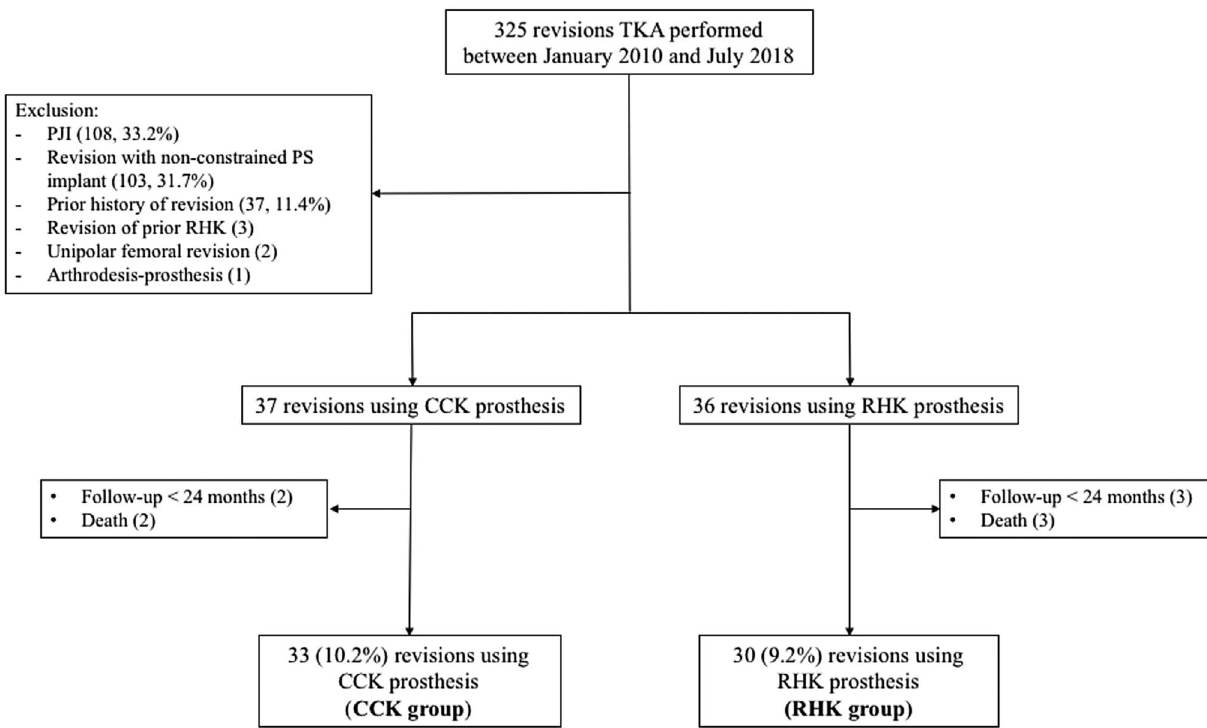
Figure 1. Study fl owchart. TKA: Total Knee Arthroplasty; CCK: Condylar Constrained Knee; RHK: Rotating hinge knee; PJI: prosthetic joint